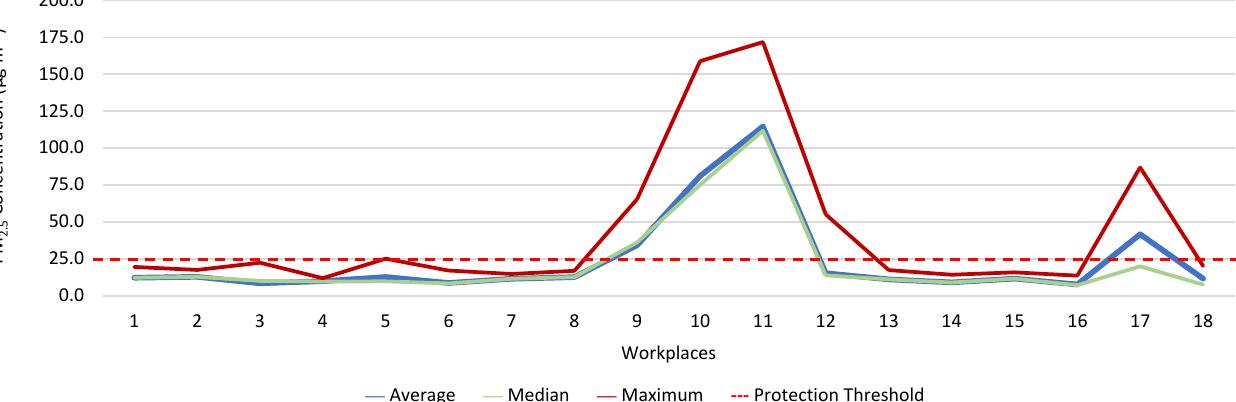
Figure 15. PM 2.5 concentration ( μ g·m − 3 ) inside workplaces.